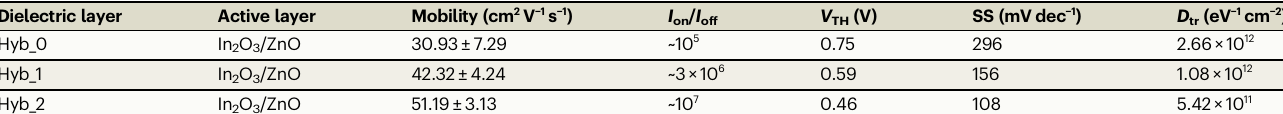
Table 1 | Electrical characteristics of In 2 O 3 /ZnO heterojunction TFTs with Hyb_0, Hyb_1, and Hyb_2 as gate